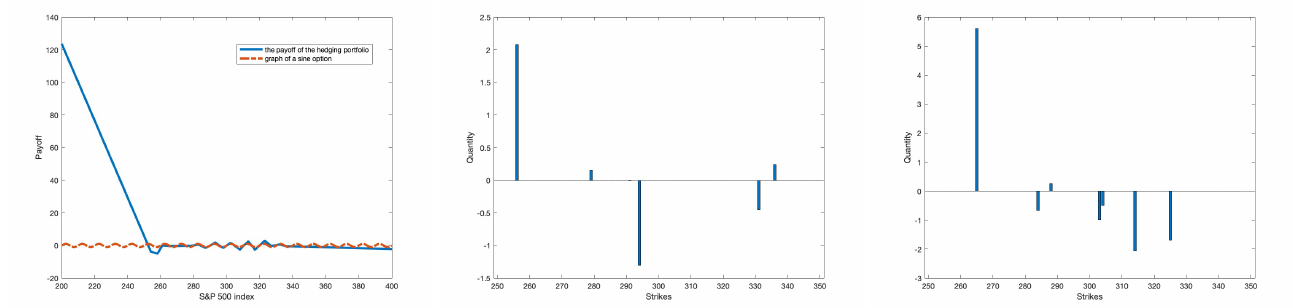
Figure 13. The payoff of the hedging portfolio together with the payoff of the claim being priced of a sine option ( left ), the hedging portfolios for the put option ( center ) and call option ( right